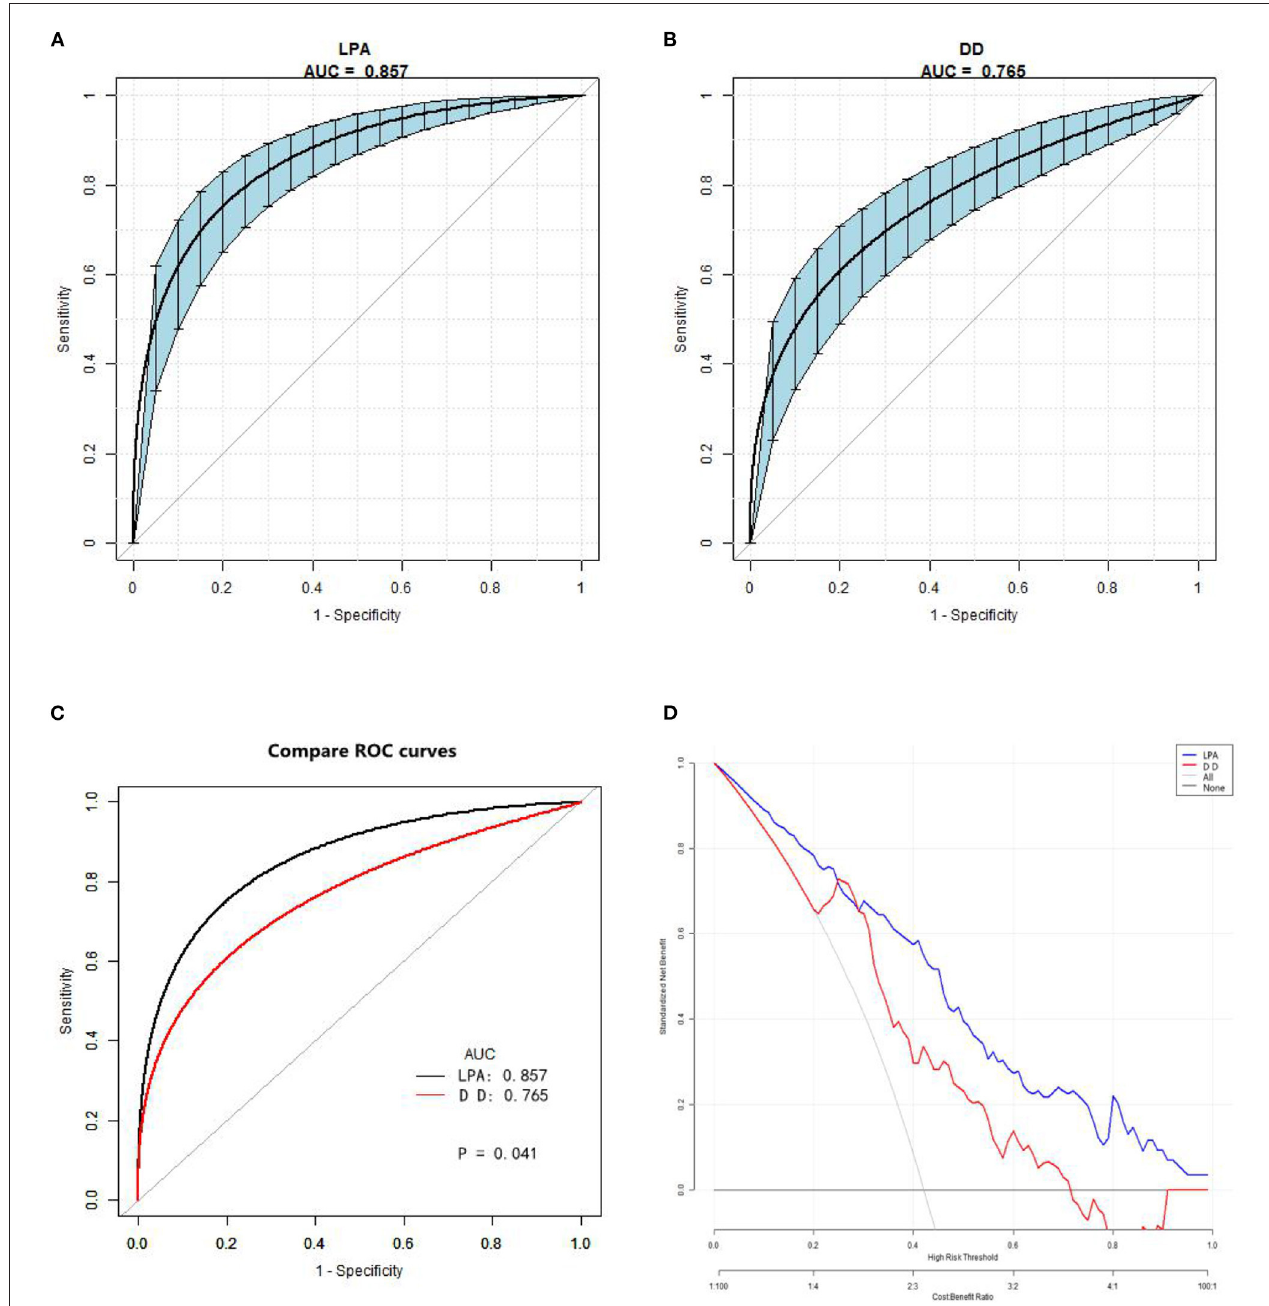
FIGURE 3 | Receiver operating characteristic and decision curve. (A) The AUC value of LPA predicting AAD. (B) The AUC value of D-dimer predicting AAD. Blue shading shows the bootstrap estimated 95% CI with AUC. (C) Comparison of ROC curves between D-dimer and LPA. The ROC curve of LPA is better than D-dimer (Delong test). (D) Decision curve for a theoretical distribution. Solid line: prediction model, LPA = blue, DD = red. Thin gray line: assume all patients have AAD. Black bottom line: assume no patients have AAD. The vertical axis displays standardized net benefit. The two horizontal axes show the correspondence between risk threshold and cost:benefit ratio. The graph gives the expected net benefit per patient associated with LPA and DD, with LPA performing better. LPA, lysophosphatidic acid; AAD, acute aortic dissection; AUC, area under the curve.